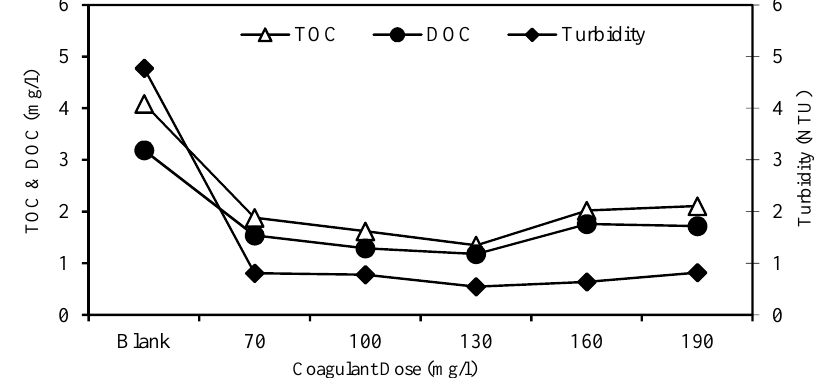
Fig. 3. Effect of FeCL 3 coagulant dosage variations on removal of TOC, DOC, and turbidity in EC process